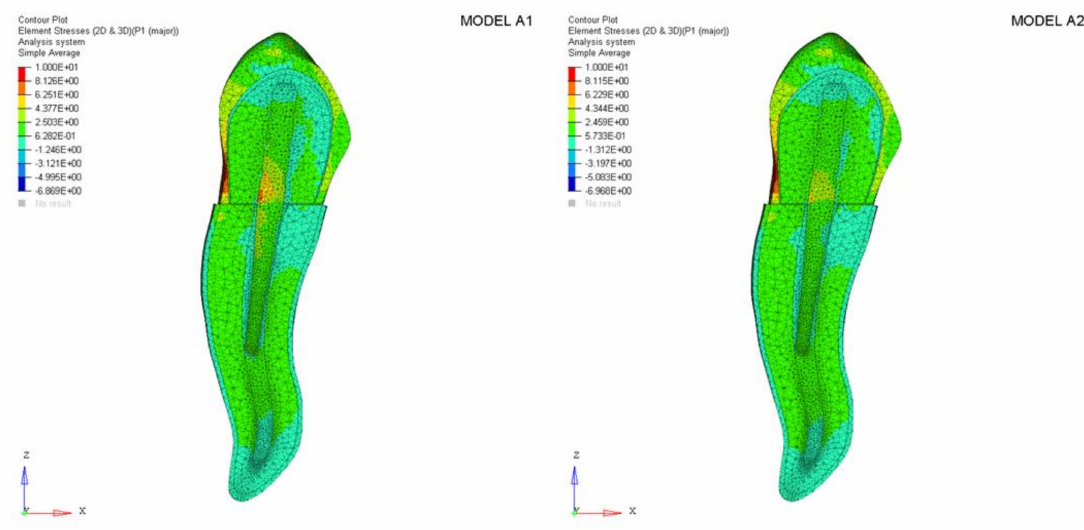
Figure 3. Models A1 and A2: Maximum principal stress distribution (MPa) in the post-restored tooth. The color scale was chosen to allow for comparison among the analyzed models.